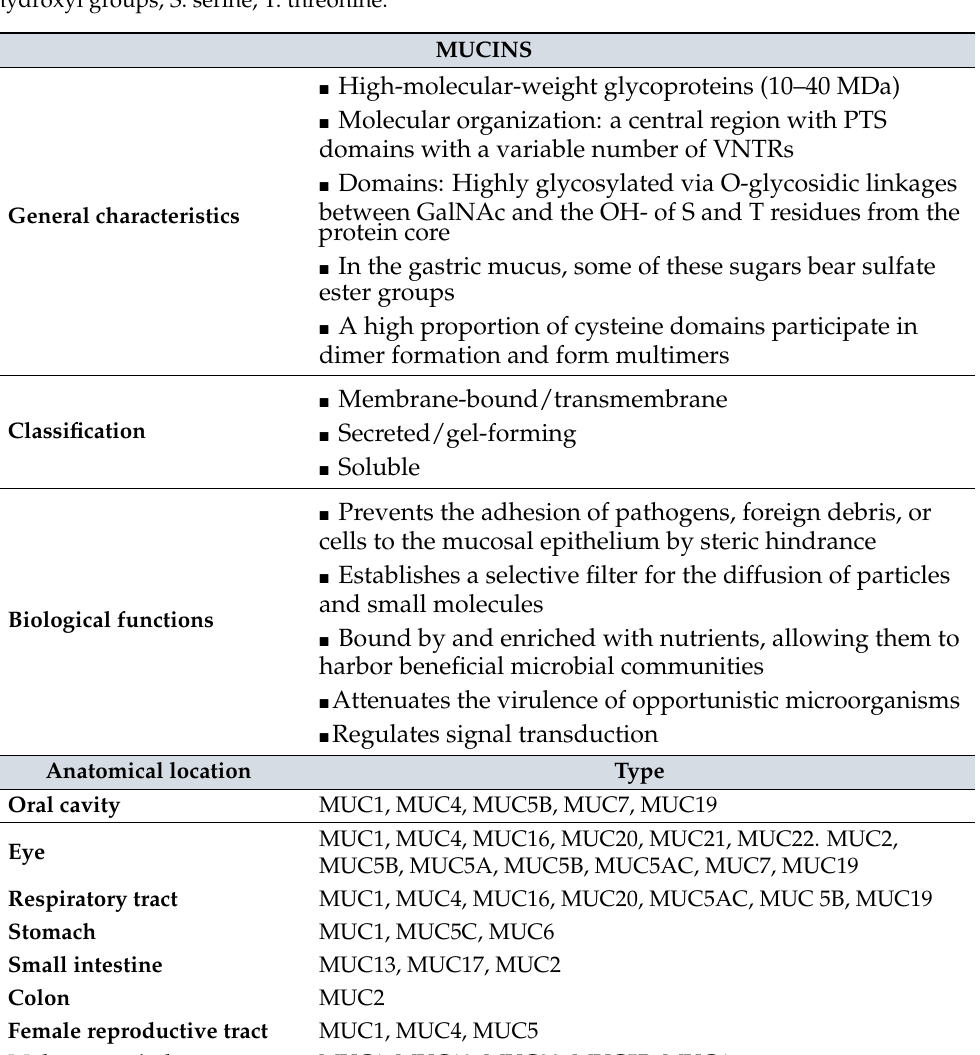
Table 2. Overview of mucins. The structural and functional details of mucins are described. Mucins (MUC) are differentially expressed in mucosal tissues. PTS domains: proline/threonine/serine- rich domains; VNTRs: variable number of tandem repeats; GalNAc: N-acetylgalactosamine; OH-: hydroxyl groups; S: serine; T: